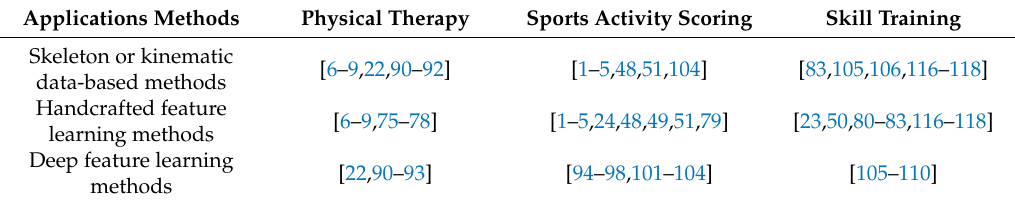
Table 1. The reviewed research works of human action evaluation.